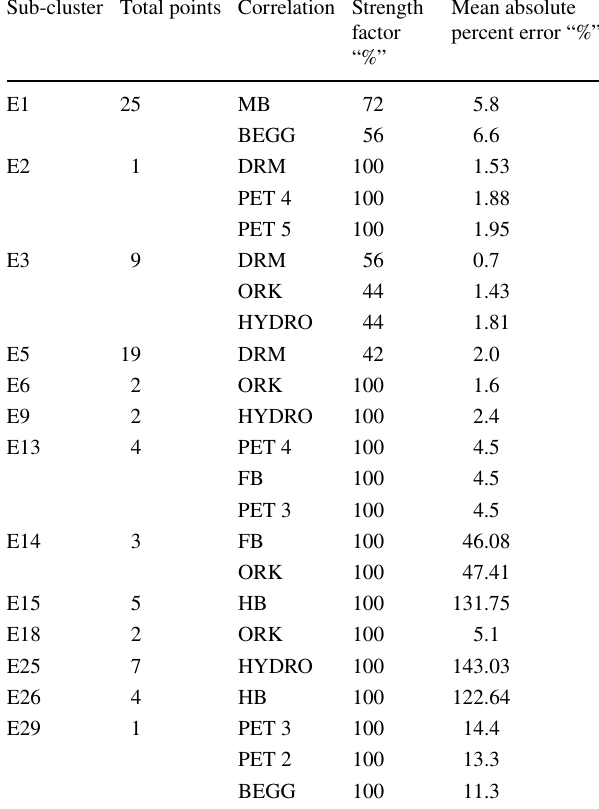
Table 14 Best correlations for cluster (F) Sub-cluster Total points Correlation Strength